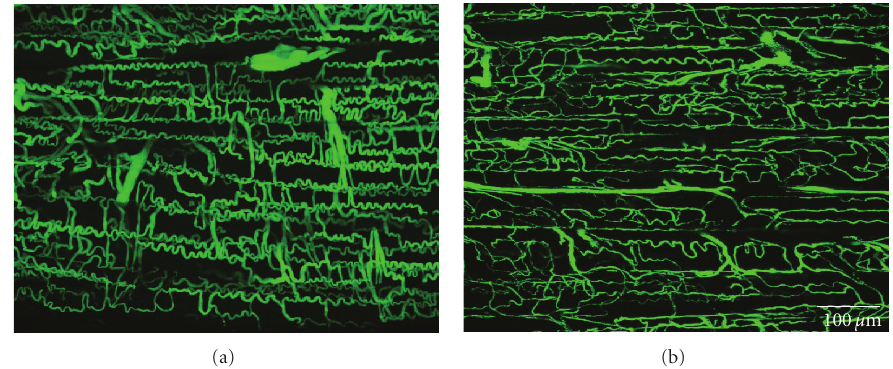
Figure 4: Confocal laser scanning microscopy images of the capillaries and anastomoses in the soleus muscle of the Cont (a) and GK (b) rats. Scale bar: 100 μ m.